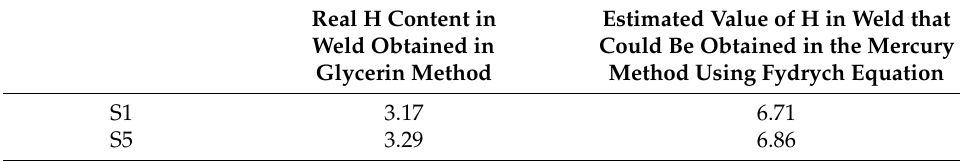
Table 6. Diffusing hydrogen content (mL/100 g of weld